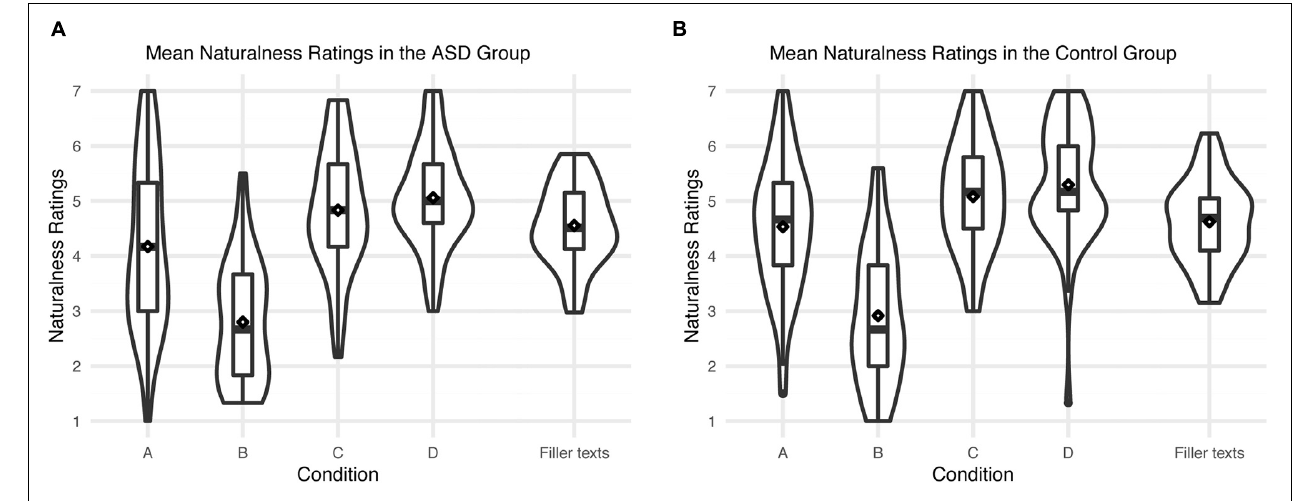
FIGURE 1 | Mean naturalness ratings for the four conditions and filler texts in the ASD group (A) and the control group (B) . Diamonds indicate means.